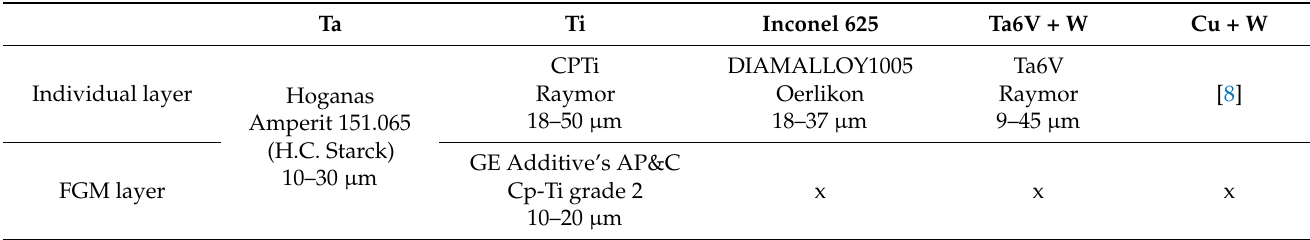
Table 2. Powder characteristics used for the cold spray